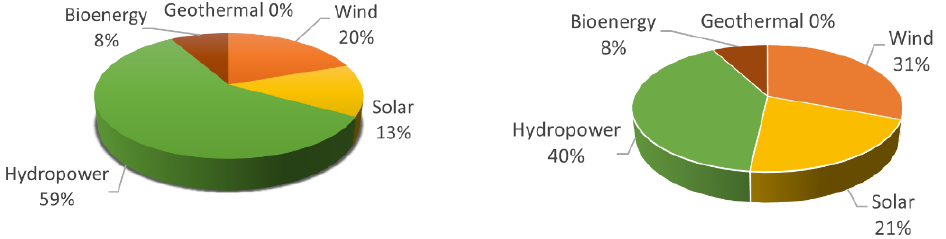
Figure 7. The structure of renewable capacity in BSR countries in 2011 and 2020. Source: own study based [46].